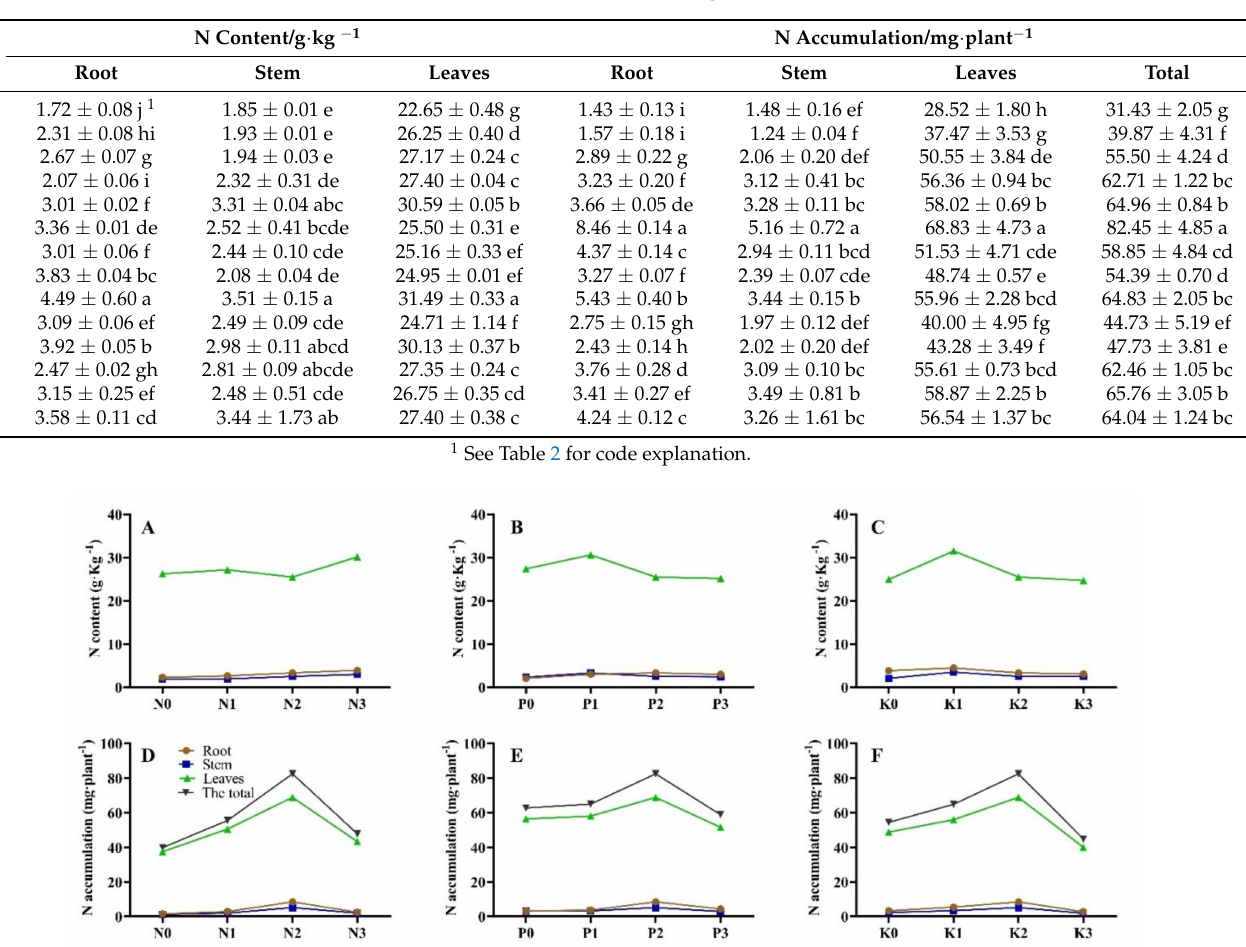
Table 4. N content and accumulation of P. bournei seedlings under different NPK fertilization.